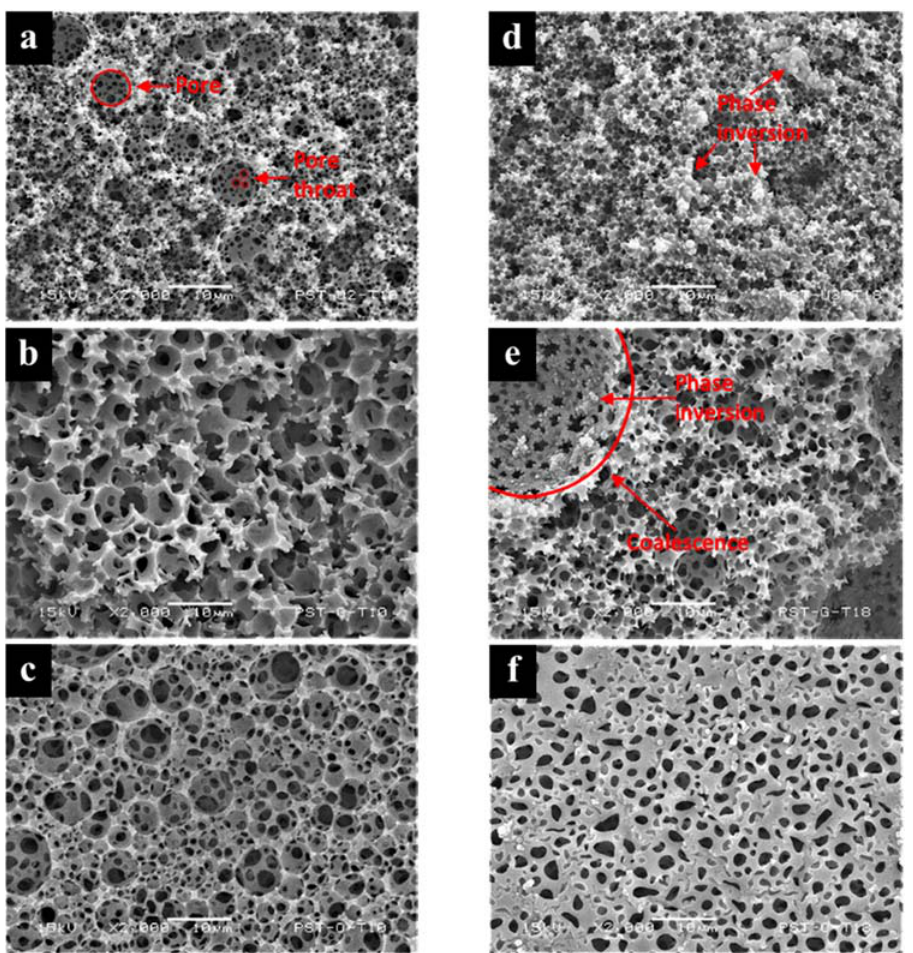
Figure 2: SEM micrographs at × 2,000 magni fi cation of St/DVB polyHIPEs post - DES extraction: ( a ) polyHIPE - U10, ( b ) polyHIPE - Gly10, ( c ) polyHIPE - OAc10, ( d ) polyHIPE - U18, ( e ) polyHIPE - Gly18, and ( f ) polyHIPE -